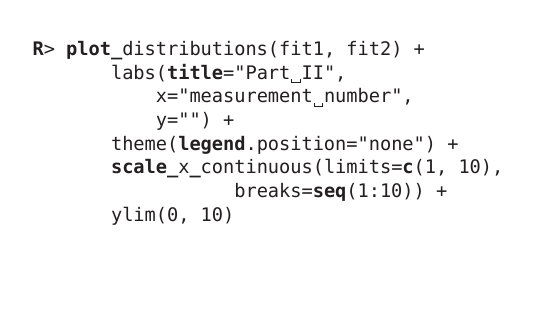
FIGURE 12 | Comparison of distributions underlying fit1 and fit2 . The hypothesis that each group formed a different adaptation level during the initial phase of the task seems to be true. The group that switches from heavy to medium weights assesses weights as lighter than they really are, while for the group that switches from light to medium the weights appear heavier. These adaptation levels fade with time and assessments converge to similar estimates of weights.